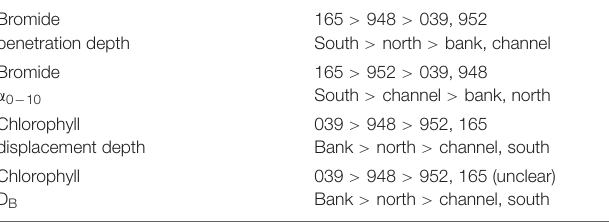
TABLE 3 | Summary of bioturbation intensities observed in Pomeranian Bay.